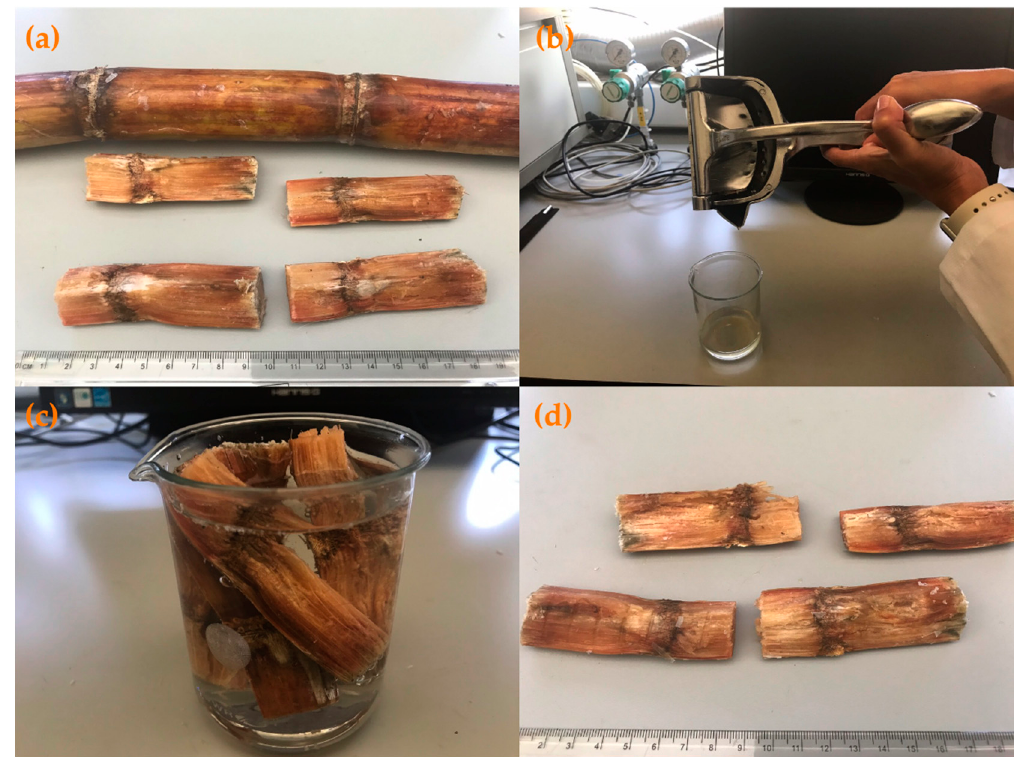
Figure 1. Process of preparing sugar cane samples to obtain bagasse. ( a ) Cutting sugar cane fragments, ( b ) juice extraction, ( c ) washing the sugarcane bagasse, and ( d ) dry fragments of sugarcane bagasse.